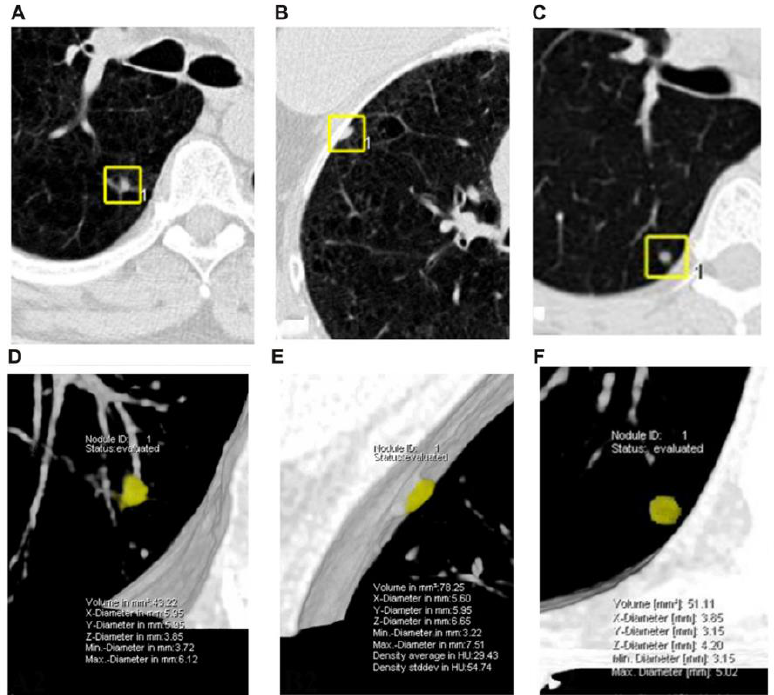
Figure 1. Lung window and 3D display of three types of nodules using the Lung CARE software. A and D are the juxta-vascular type. B and E are the juxta-pleural type. C and F are the isolated nodule